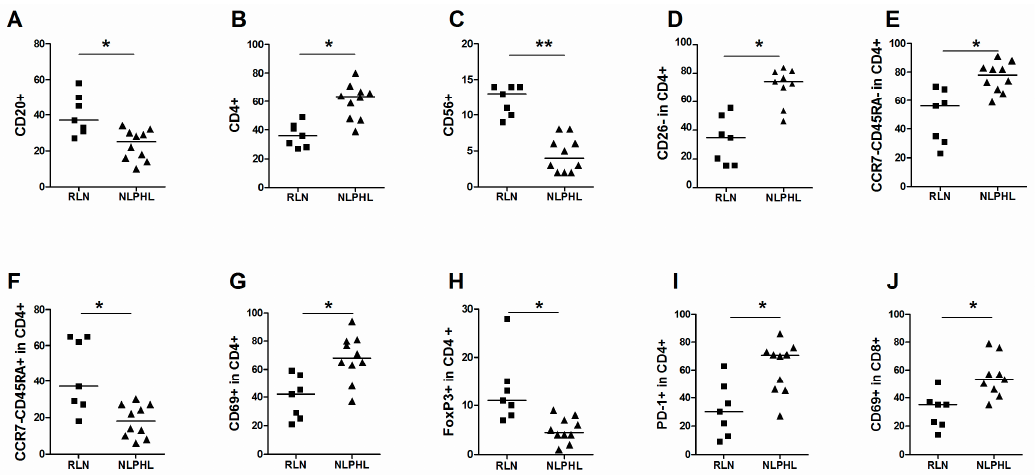
Figure 1. Comparison of cell populations in RLN and NLPHL. Median percentage of each group and significant changes according to p-value (0.001 < * <0.01, ** < 0.001) are indicated in each graph. Main cell populations of ( A ) CD20+; ( B ) CD4+ and ( C ) CD56+ cells. Subpopulations ( D ) CD26- in CD4+ cells; ( E ) CCR7-CD45RA- in CD4+ cells; ( F ) CCR7-CD45RA+ in CD4+ cells; ( G ) CD69+ in CD4+ cells; ( H ) FoxP3+ in CD4+ cells; ( I ) PD-1+ in CD4+ cells; and ( J ) CD69+ in CD8+ cells.